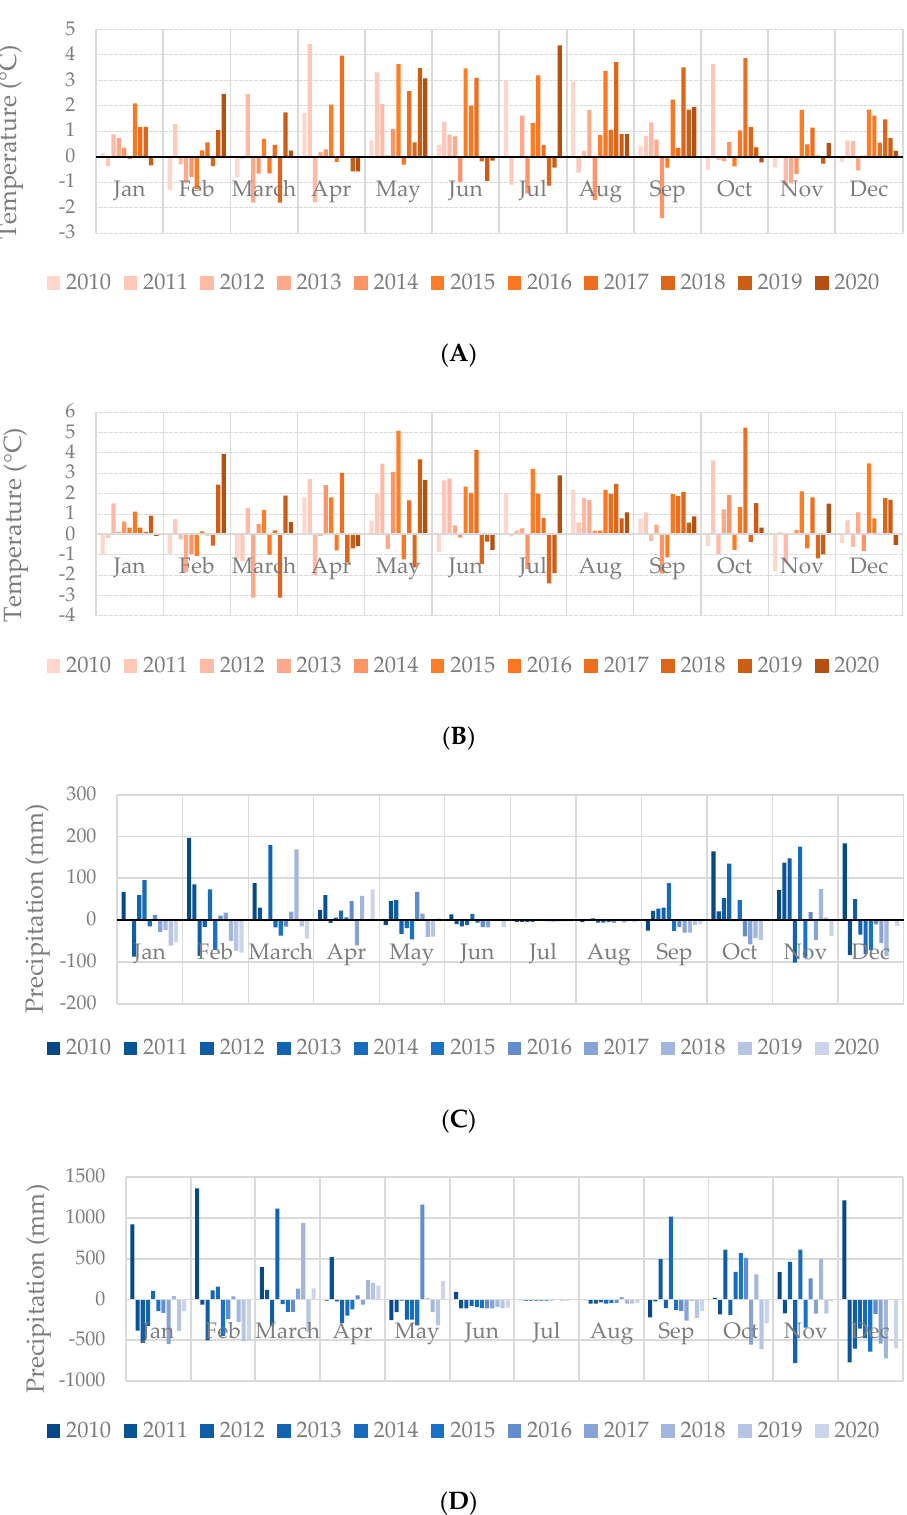
Figure 5. Anomalies registered in maximum temperatures from 2010 to 2020 in ( A ) Lisbon and ( B ) Seville; Analysis of rainfall during the last decade in ( C ) Lisbon and ( D ) Seville. The rating given by tourists on the website varies depending on the month